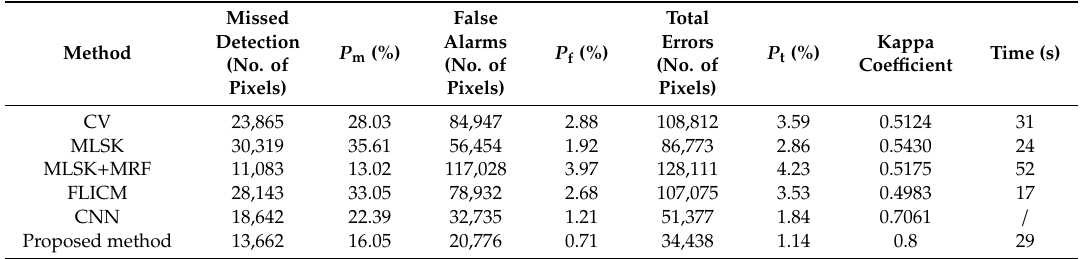
Table 2. Quantitative experimental results compared with popular CD